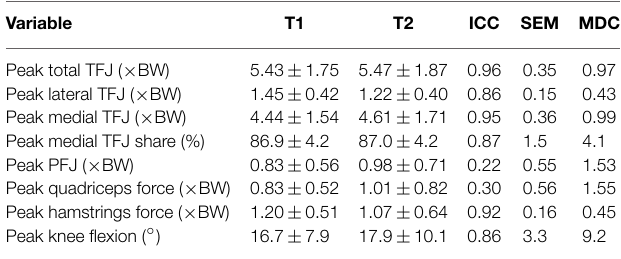
TABLE 6 | Test–retest reliability measures of peak values for nine participants during stair ascent [mean (cid:6) SD, intra-class correlation coefficient (ICC), SEM, and minimal detectable change